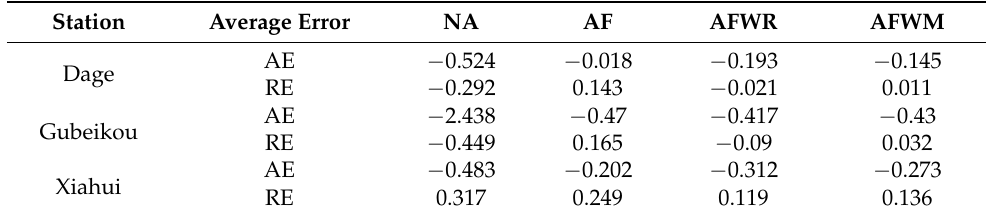
Table 3. Average error values of the four assimilation settings for the three stations.